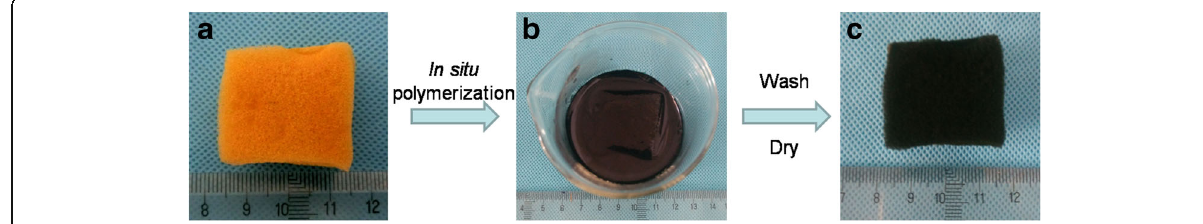
Fig. 1 The process of preparing PANI/sponge composite. a A commercial grade polyurethane sponge was selected. b In situ polymerization of PANI on the sponge. c The sample was washed with DI water and dried at room temperature to obtain the final PANI/sponge